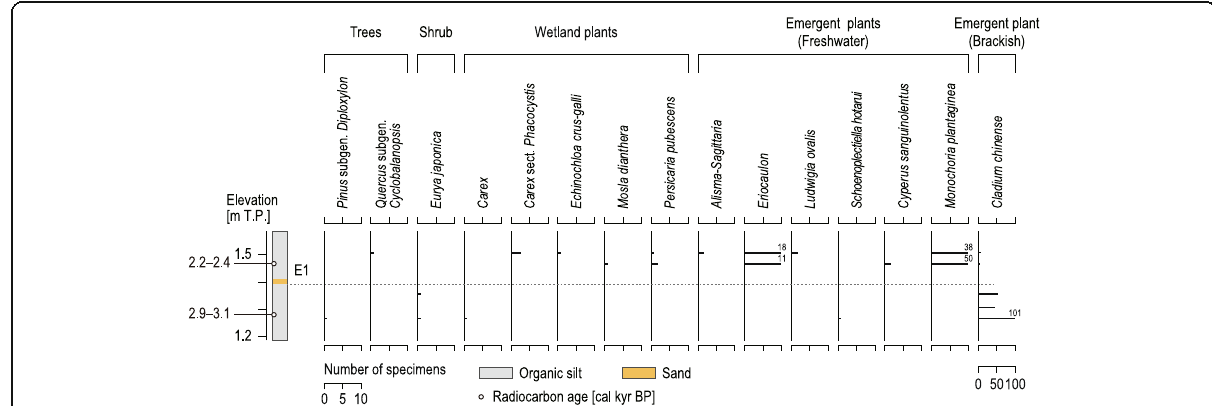
Fig. 6 Plant macrofossil assemblages between 1.18 and 1.58 m elevation in core MG10. Numbers of specimens exceeding 10 appear above the